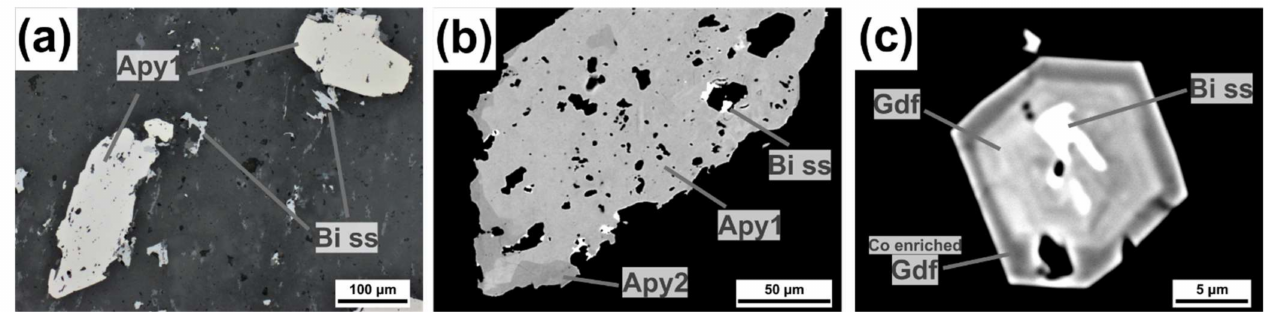
Figure 18. Reflected-light image ( a ) and back-scattered electron (BSE) images ( b,c ) showing sulfarsenides from the Kizhnica hornfels: ( a ) early arsenopyrite with younger Bi sulfosalts crystals; ( b ) corroded and porous early arsenopyrite crystal containing Bi sulfosalts inclusions with younger arsenopyrite crystallized in the outer zones; ( c ) inclusions of Bi sulfosalts in euhedral gersdorffite crystal with regular zonation and outer zone enriched in Co. Abbreviations: Apy = arsenopyrite; Bi ss = bismuth sulfosalts; Gdf =